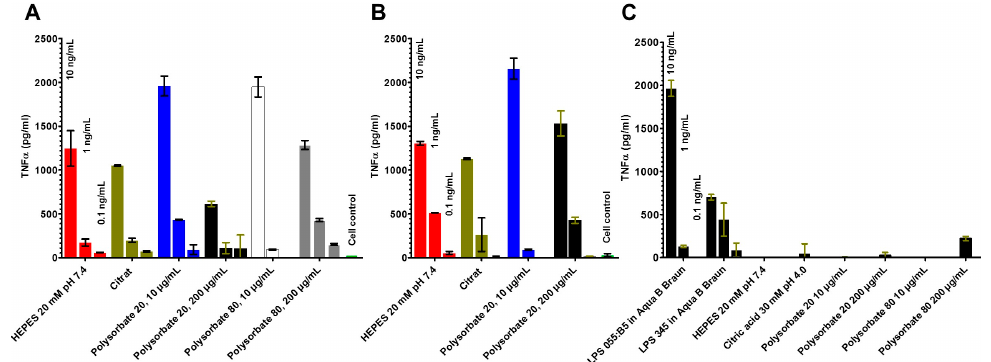
Figure 3. Secretion of tumor-necrosis-factor α (TNF- α ) by human mononuclear cells induced by LPS from E. coli O55:B5. LPS aggregates were prepared in NaCl 0.9% and polysorbate 20 and 80. Three LPS concentrations 10, 1 and 0.1 ng/mL were tested. The error bar comes from two-fold determination of TNF- α concentration in the ELISA.